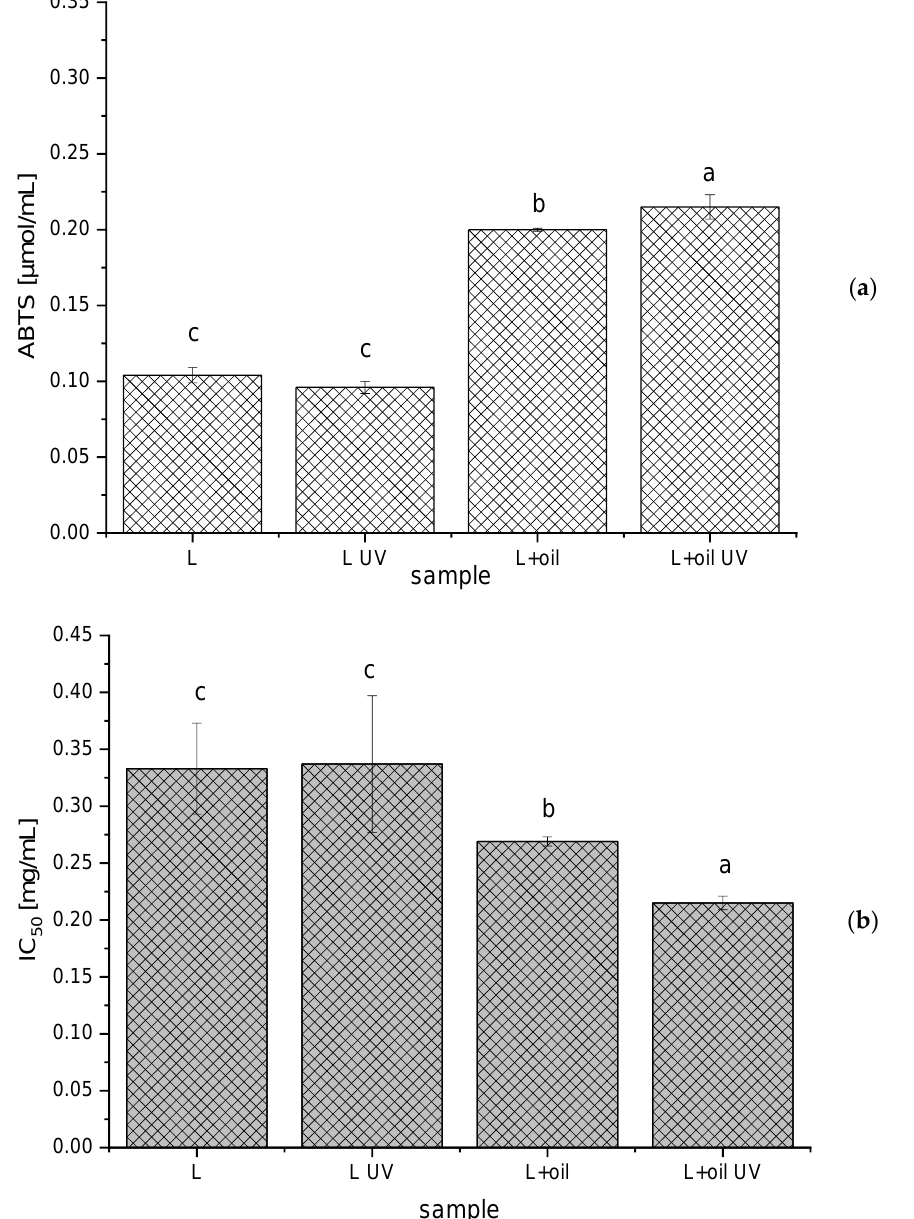
Figure 4. Antioxidant capacity of the empty and Rosa canina seed oil-loaded liposomes (non-treated and UV-irradiated) obtained in the ABTS ( a ) and DPPH ( b ) assays; IC 50 , the concentration of the liposomes required to scavenge 50% of the DPPH radicals; values with different letters ( a – c ) showed statistically significant differences ( p < 0.05; n = 3; analysis of variance, Duncan’s post-hoc test). Statistically the significantly higher ABTS radical scavenging potential and the lower IC 50 (higher DPPH radical scavenging activity) for the UV-irradiated sample with rosehip